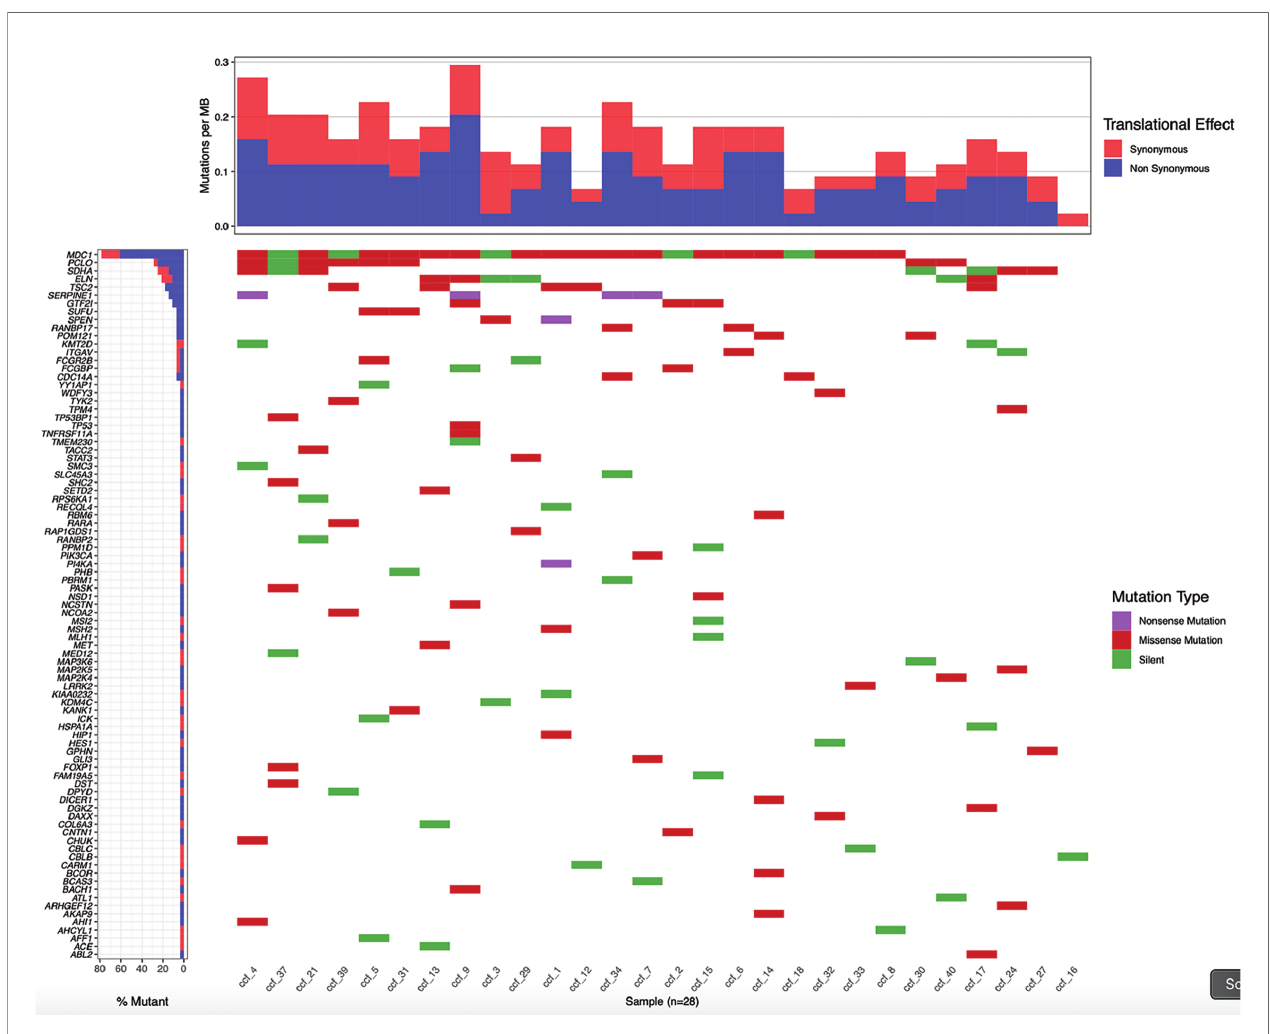
FIGURE 5 | Patient-speci fi c candidate PCa somatic variants from biopsy samples. Waterfall plot representing 188 candidate somatic variants detected in 28 prostate biopsy samples by targeted RNA sequencing. Each column represents a sample and each row a gene. Mutations are colored according to the predicted functional consequence. The plot was generated using the GenVisR Bioconductor